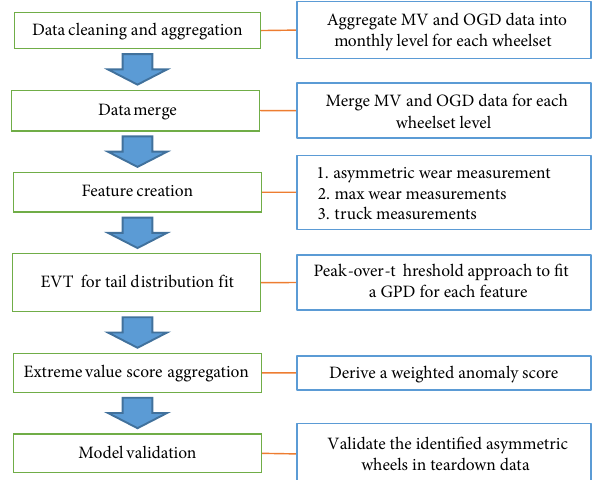
Figure 2. Flow chart of the proposed algorithm for identification asymmetric wheel